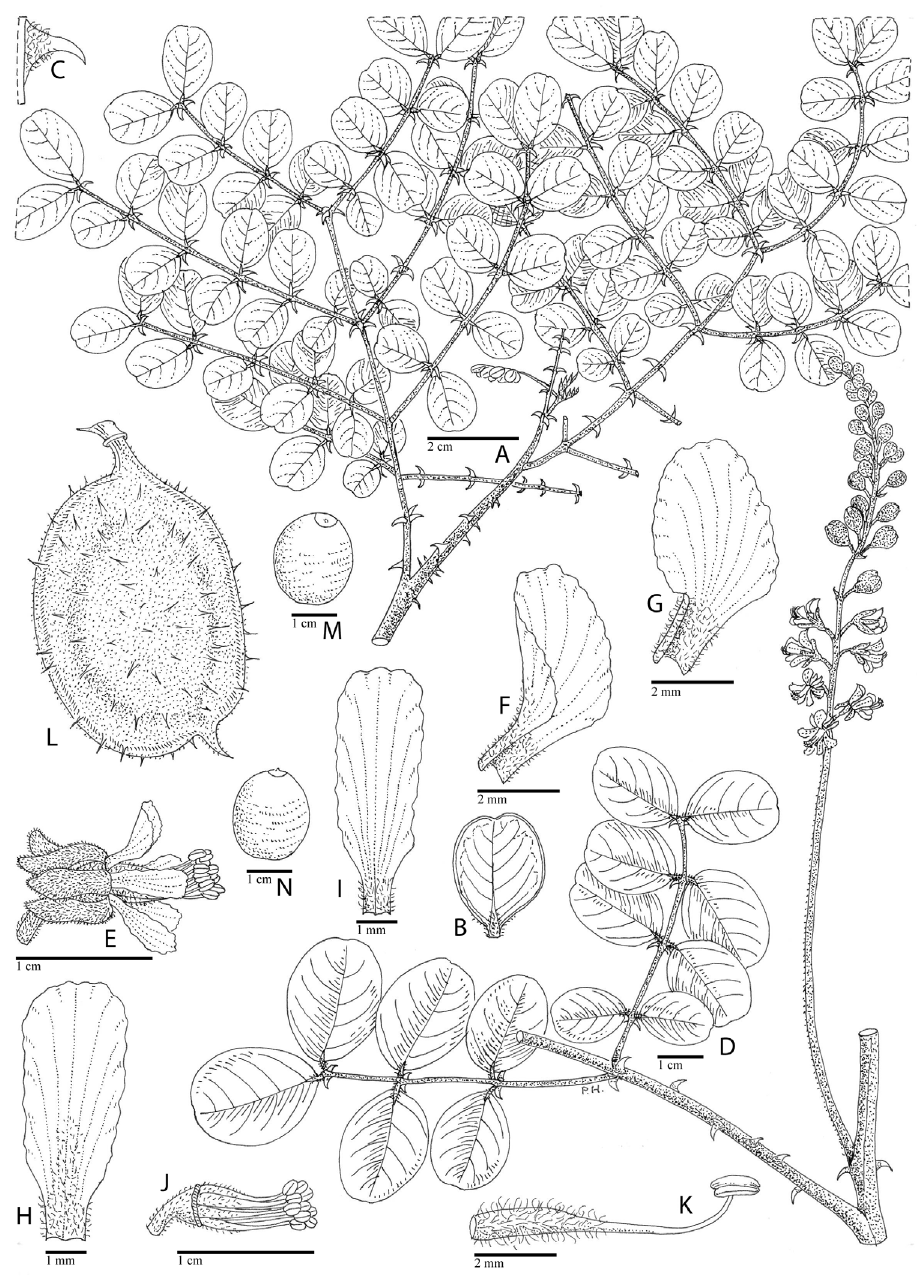
Figure 19. Guilandina ciliata Bergius ex Wikstrom. A foliage B leaflet undersurface C prickle en- larged to show indumentum D inflorescence and portion of leaf; E flower F, G median petal H upper lateral petal (outer surface) I lower lateral petal (inner surface) J stamens K stamen L fruit M, N seeds. A–C from Ekman 5413 D–K from Curtiss 143 L–N from Pannell 179. Drawn by Pat